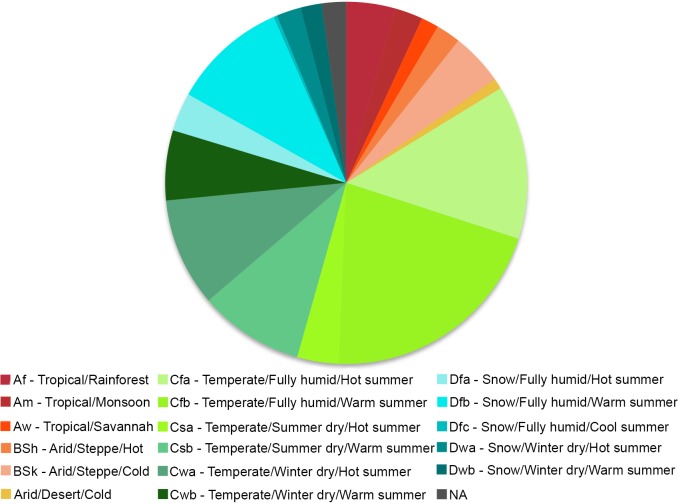
Study cases per Köppen-Geiger climate class.Percent distribution of study cases according to climate classes using the Köppen-Geiger classification system. The main climate groups include: (A) tropical, (B) dry arid and semiarid, (C) mild temperate, (D) continental, and (E) polar/alpine. The subgroups are divided according to average annual and monthly temperatures, total precipitation and precipitation seasonality.